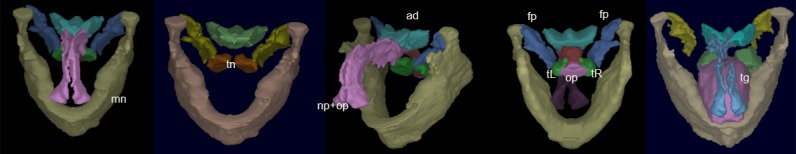
3D surface renditions of some segmented objects from one subject.Objects shown in different combinations are: np (nasopharynx), op (oropharynx), mn (mandible), tn (tonsils), tL & tR (left and right tonsil), fp (fat pad), ad (adenoid), tg (tongue).